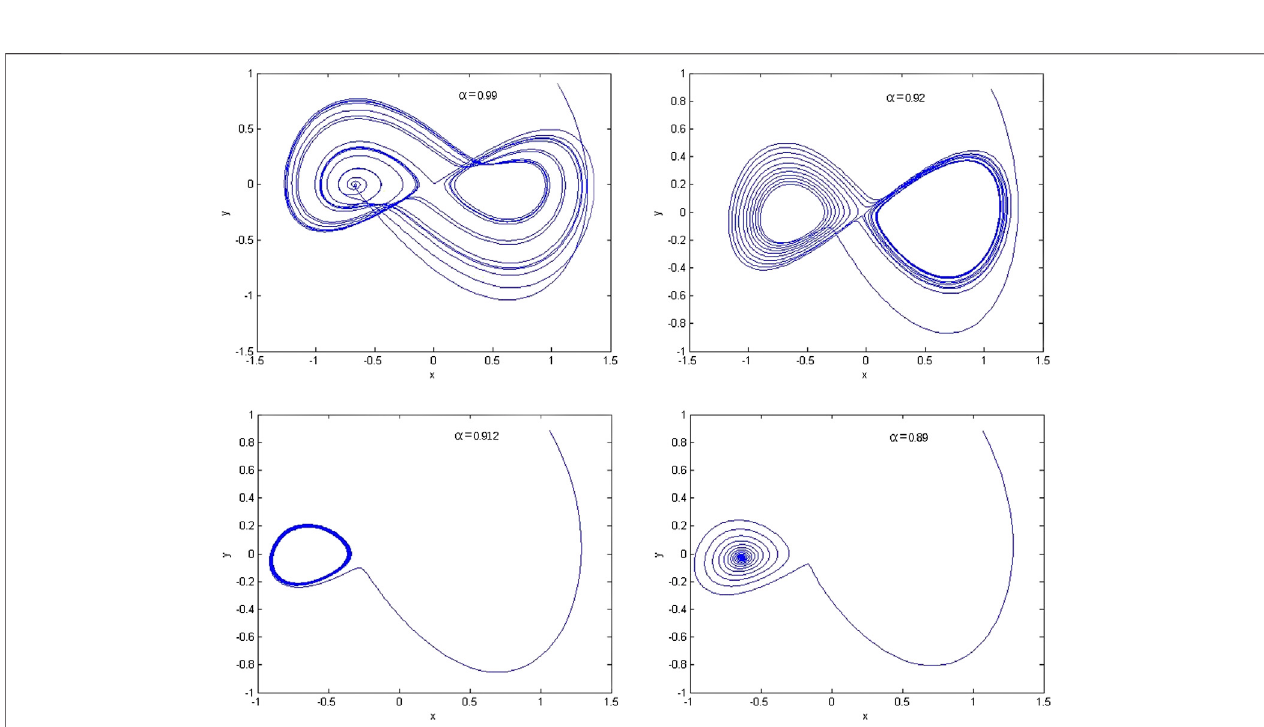
FIGURE 5 | Phase portraits of model Eq. 2.9 with q 2 (cid:1) q 3 (cid:1) 1.